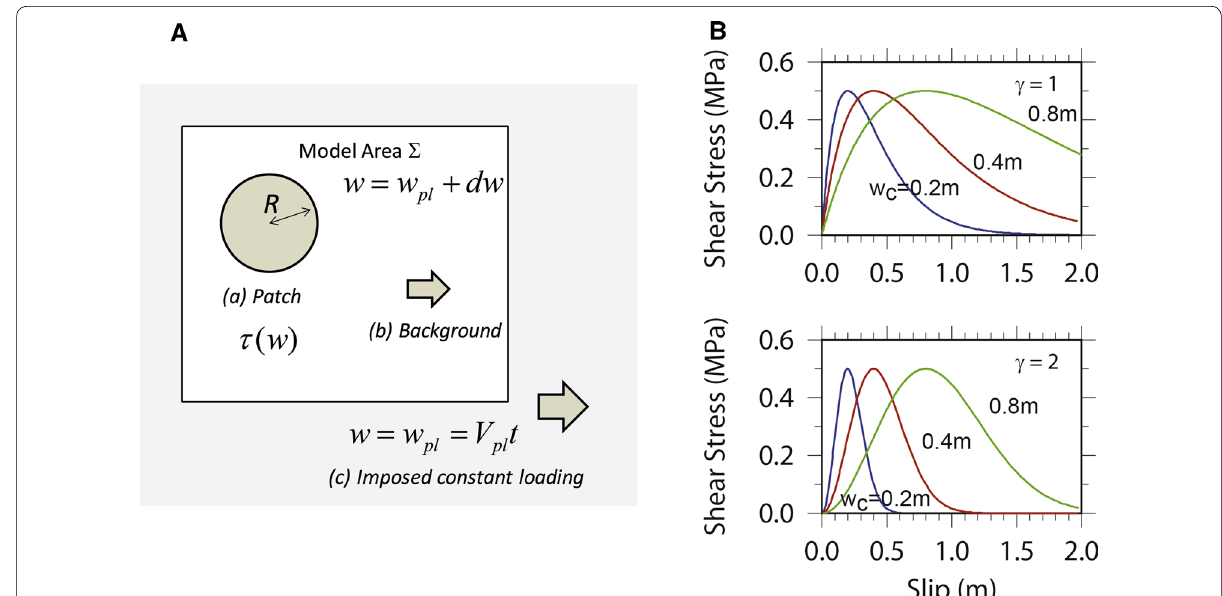
Fig. 1 A Schematic illustration of the model configuration for a single patch surrounded by aseismic slip. The model area is described by: a a patch with radius R , governed by a friction law that is dependent on the parameters of the patch; b the background, which may possess a zero-friction condition or simply be the largest patch existing behind a ; and c a constant loading outside of the model area. The infinite domain Σ ∞ from Eq. (2) consists of a to c , while the modeled area is limited to a and b . B Examples of frictional behavior, from Eq. (4), with γ = 1,2 and w c = 0.2,0.4, and 0.8 m . In this case, �τ = 0.5 MPa and w 0 = 0